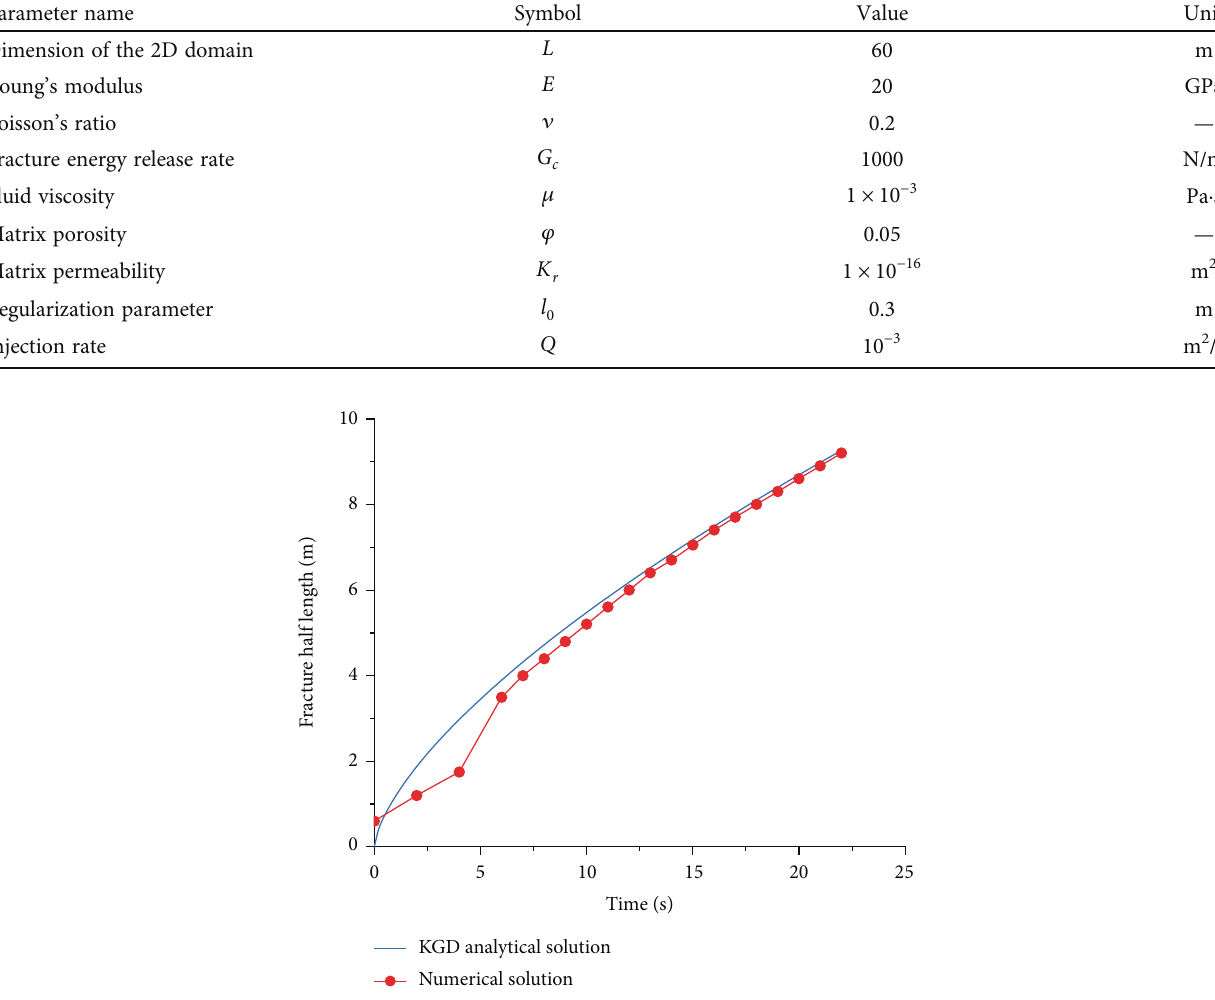
Table 1: Model validation parameters.